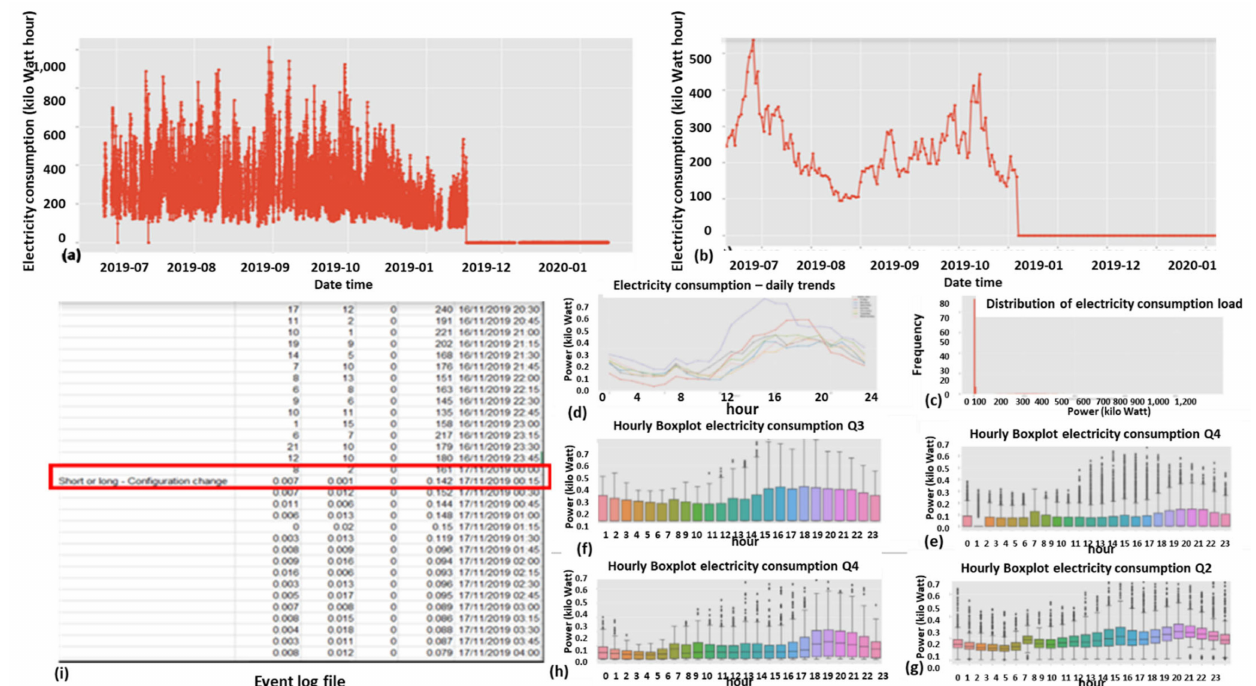
Figure 23. ( a ) Load profile at MDM, ( b ) load profile at the data warehouse. The load profiles are equal, ( c ) energy distribution appears shaved, ( d ) daily-hourly trends look normal, ( e – h ) seasonal-hourly boxplots Q1–Q4 appears continuous but with plenty of outliers. ( i ) event log with timestamp marking of the start of the